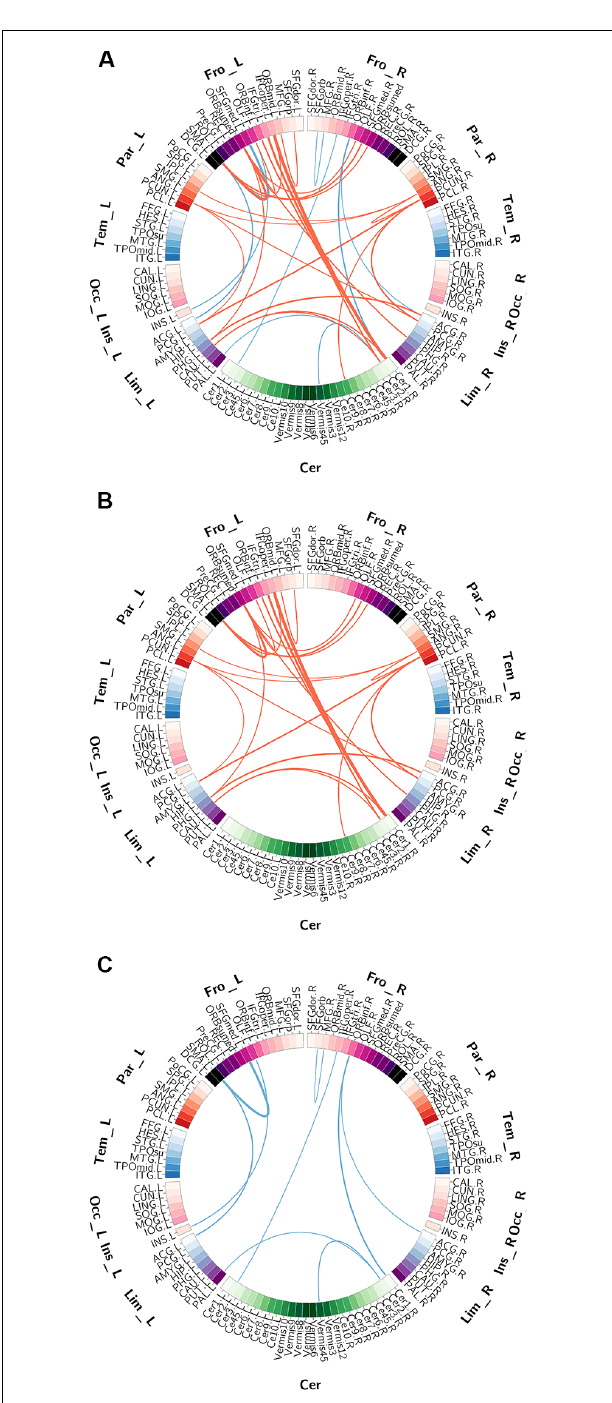
FIGURE 2 | The gender differences in functional connectivity (FC) detected using two-sample t -tests. Panel (A) shows all FCs significant gender differences. Panel (B) shows the FCs significantly higher in females than in males. Panel (C) shows the FCs significantly higher in males than in females. Brain regions are represented by squares on a circle and the FCs between them are represented by the lines connecting two regions. The red lines represent higher FC in females than in males and the blue lines represent higher FC in males than in females. The thickness of the lines represents the corresponding T